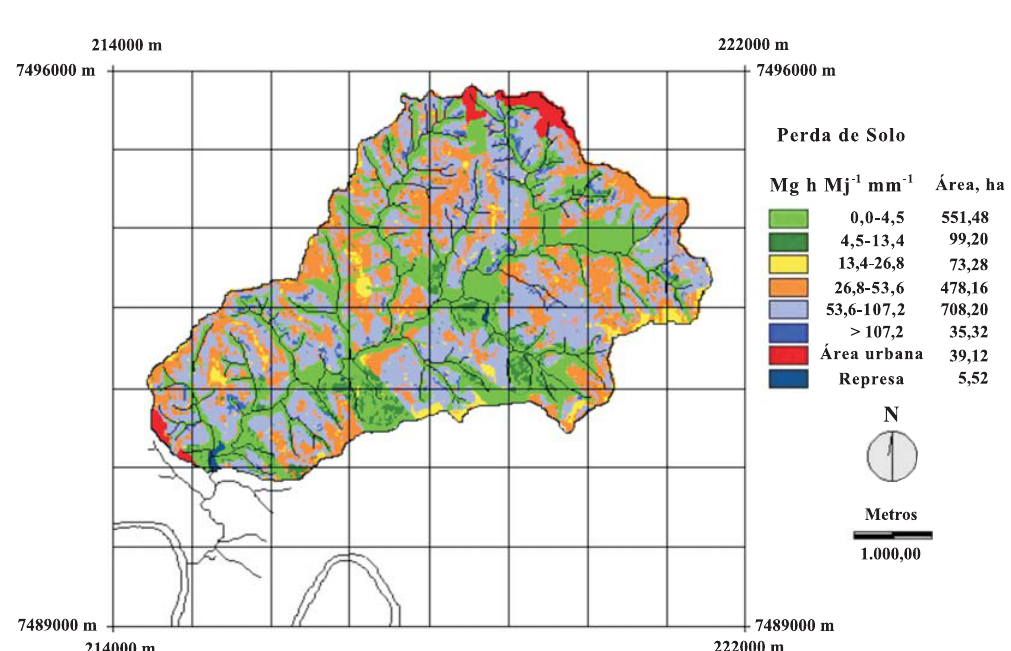
Figura 7. Estimativa da perda de solo (A, em Mg ha -1 ano -1 ) e ocorrência (área, em hectares) na área de